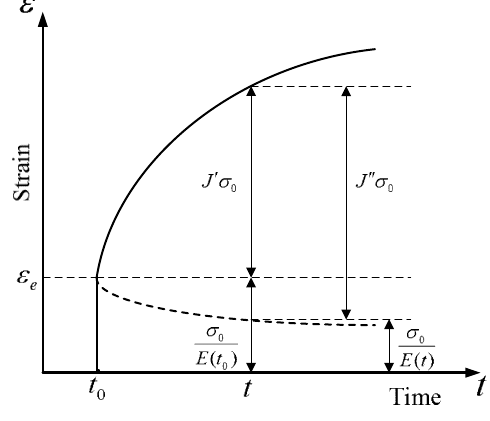
Figure 1. Schematic description of age-dependent strains.